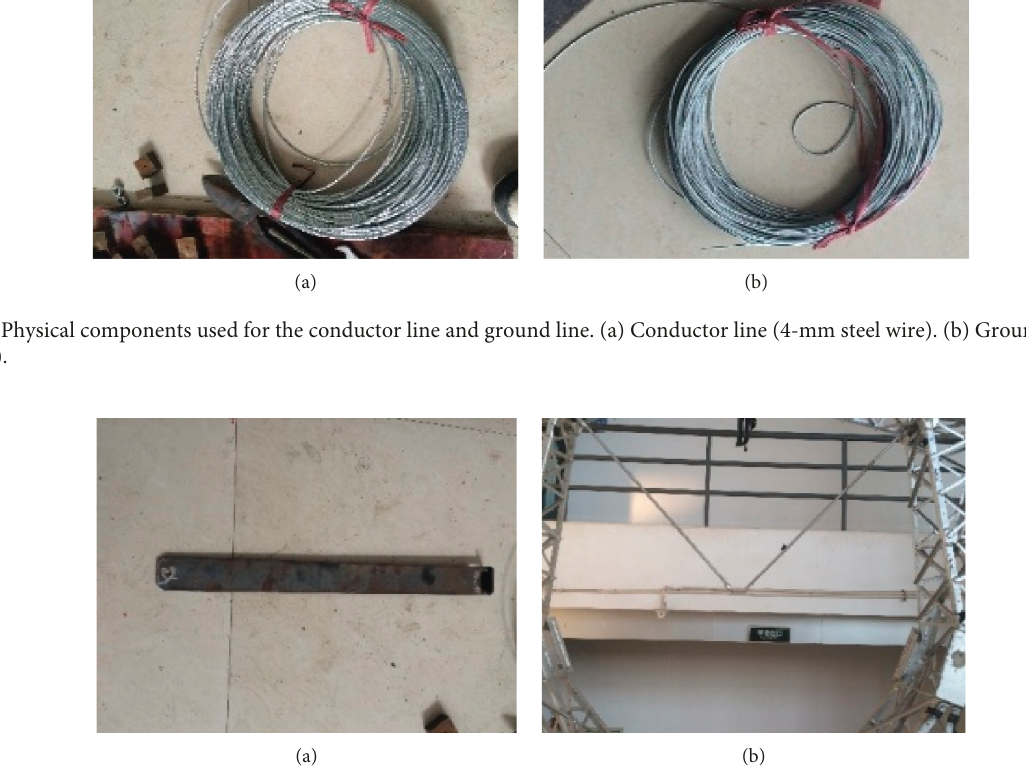
Figure 4: Physical components used for the insulator models. (a) I-shaped insulator model. (b) V-shaped insulator model.